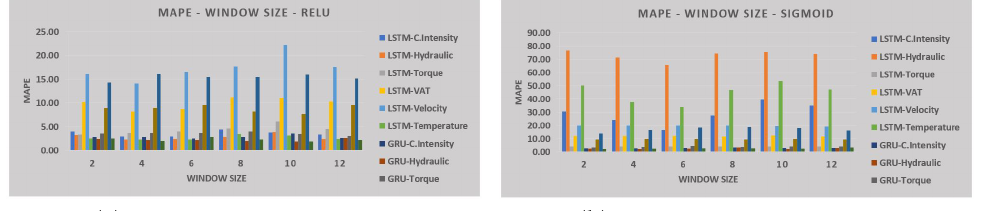
( a ) MAPE using ReLU activation ( b ) MAPE using sigmoid activation